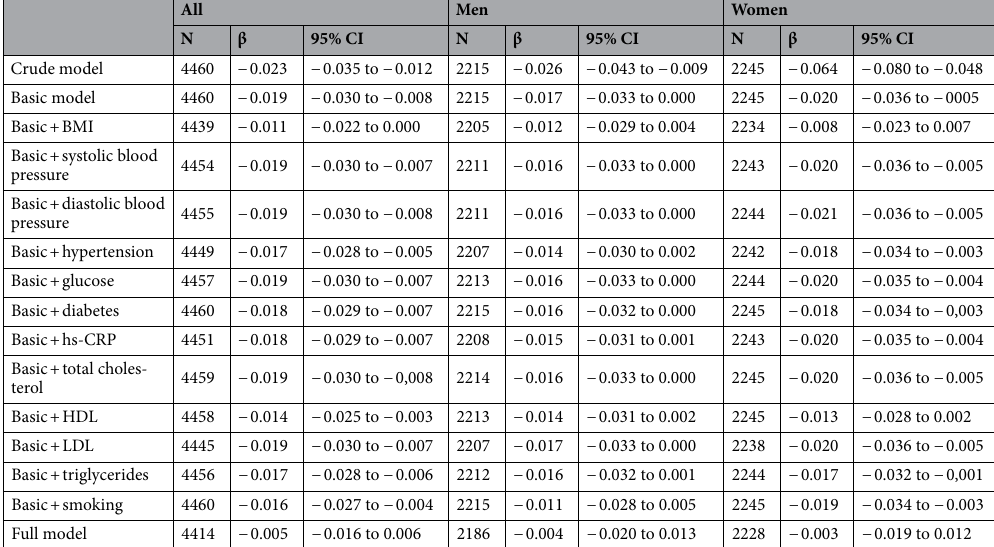
Table 2. Beta estimates and 95% confidence intervals (95% CI) for the association of education (per 5 years of education) with cystatin C in linear regression models (basic model: adjusted for age (+ sex); full model: age (+ sex), BMI, hypertension, diabetes, hs-CRP, total cholesterol, HDL, triglycerides, smoking).